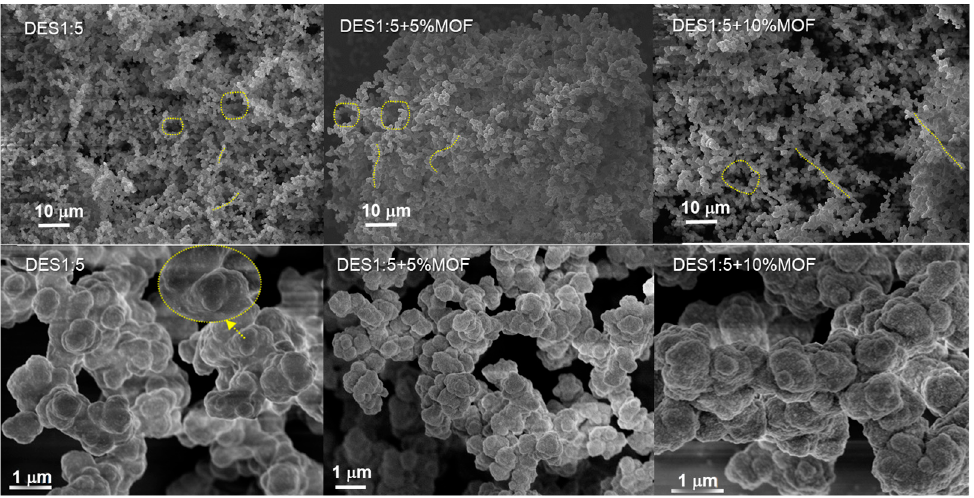
Figure 2. Typical SEM images of the LRF cryogels doped by MOF at DES1:5 (10 µm and 1 µm).